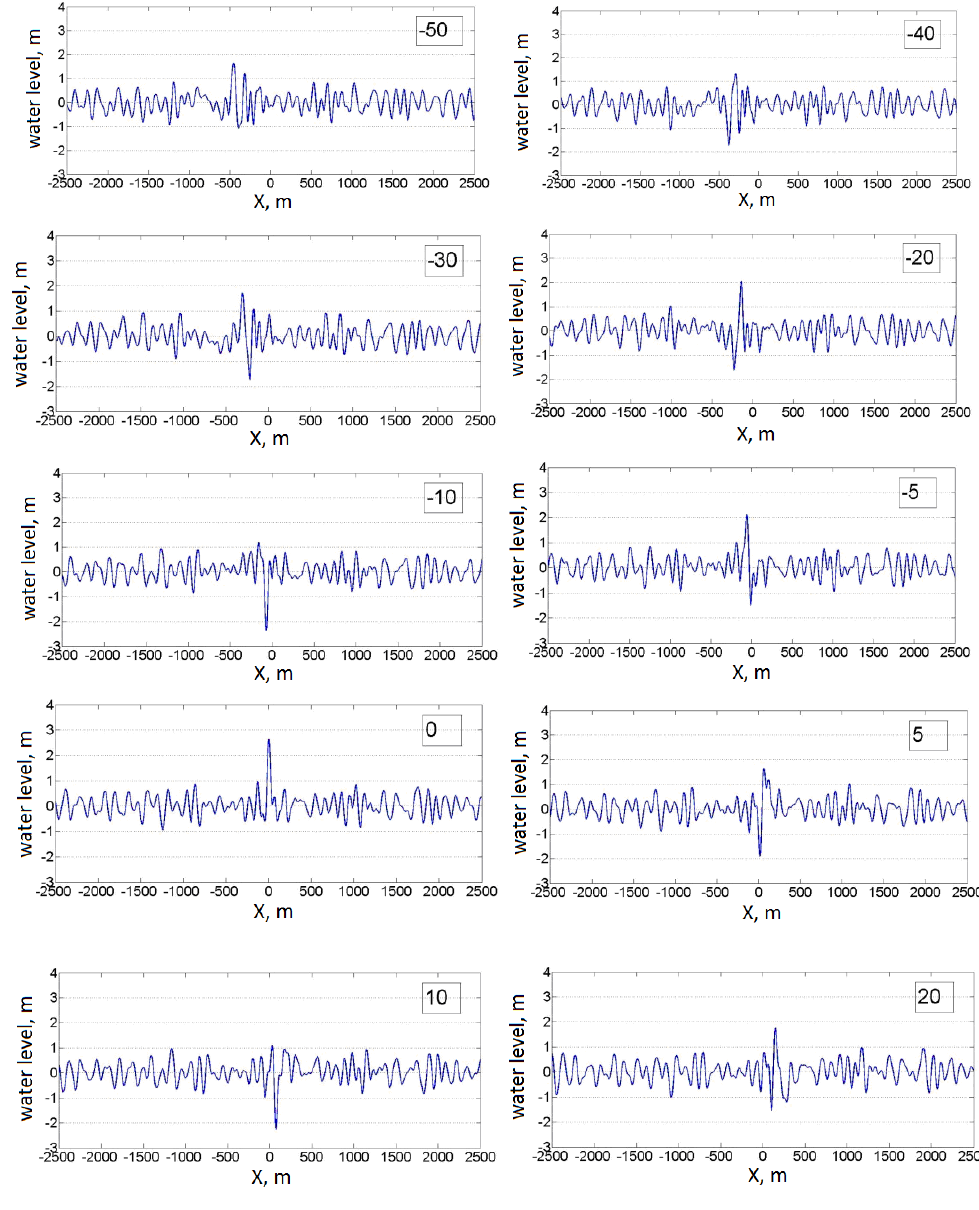
Fig. 7. Snapshots of water level for different times (s) Thus, in the case of the focusing wave packets, as shown above, the apparent abnormal wave in the form of a crest appears in approximately 1 minute prior to its approach to the ship at the distance about 600-700 m. If the observer is on board, who also "prescribes" water level fluctuations in pitching; he can see only a big crest. This crest can be seen a few times (2 - 4